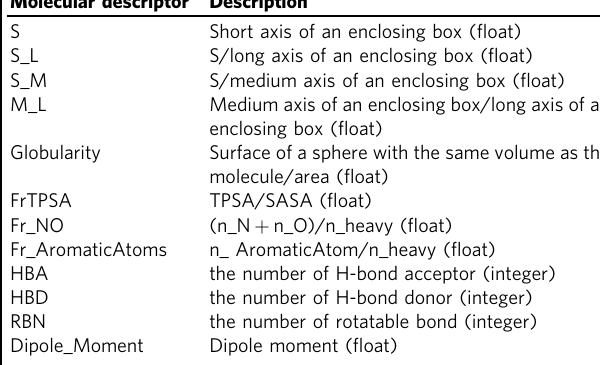
Table 2 Molecular descriptors used as the global state in